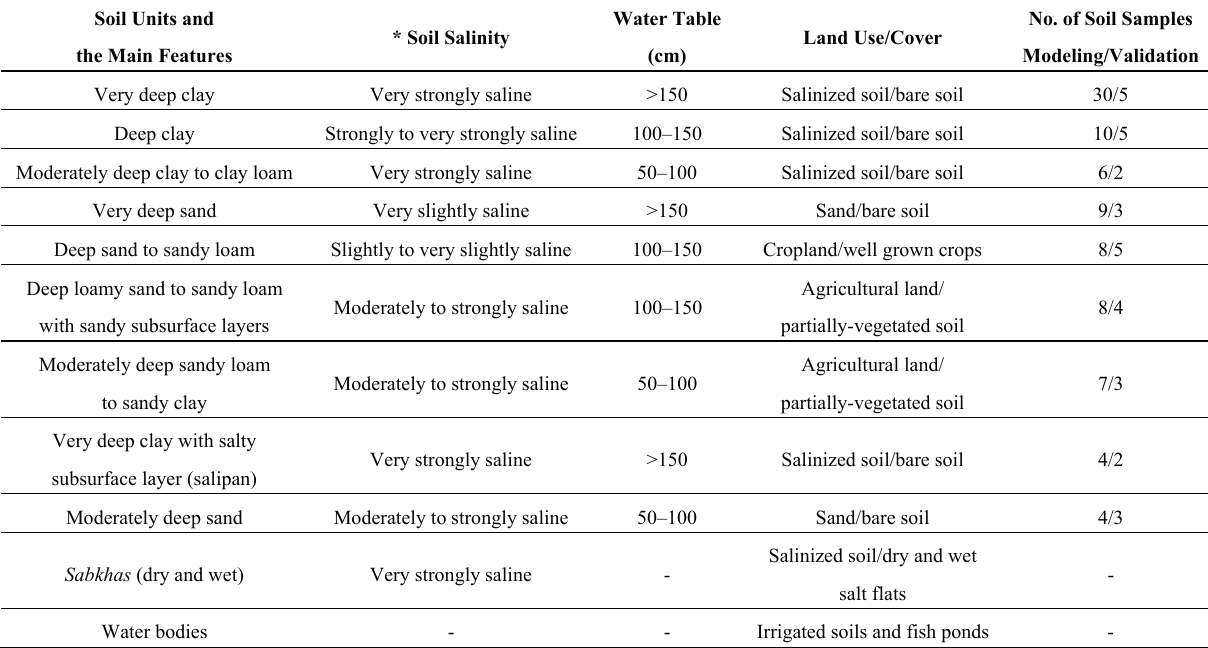
Table 1. Distribution of soil samples in main soil units and land use